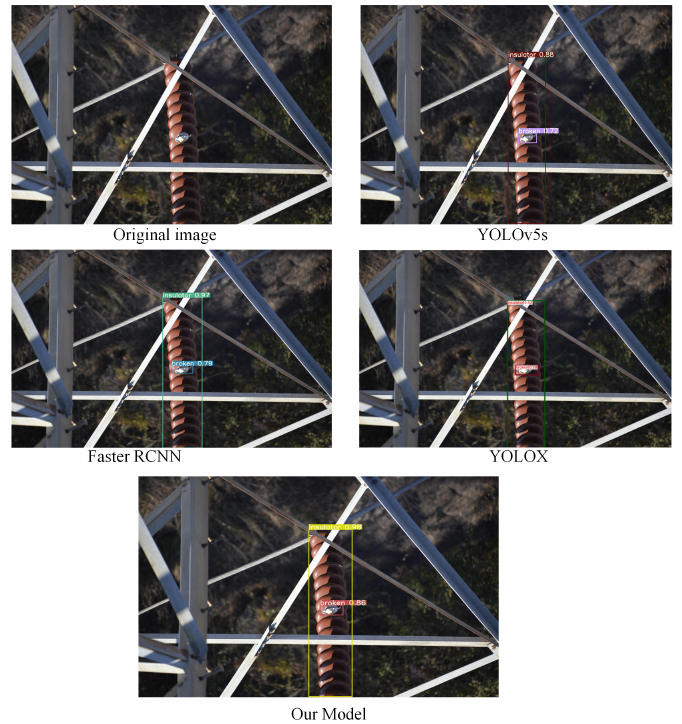
Figure 18. Detection results of images with obscured objects and complex